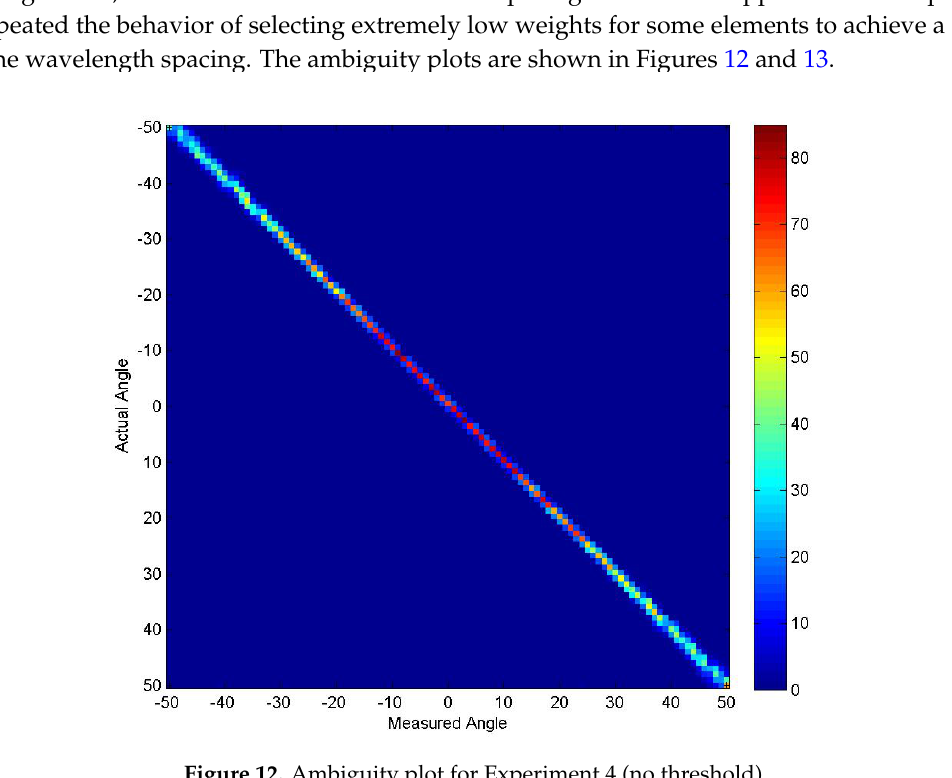
Figure 12. Ambiguity plot for Experiment 4 (no